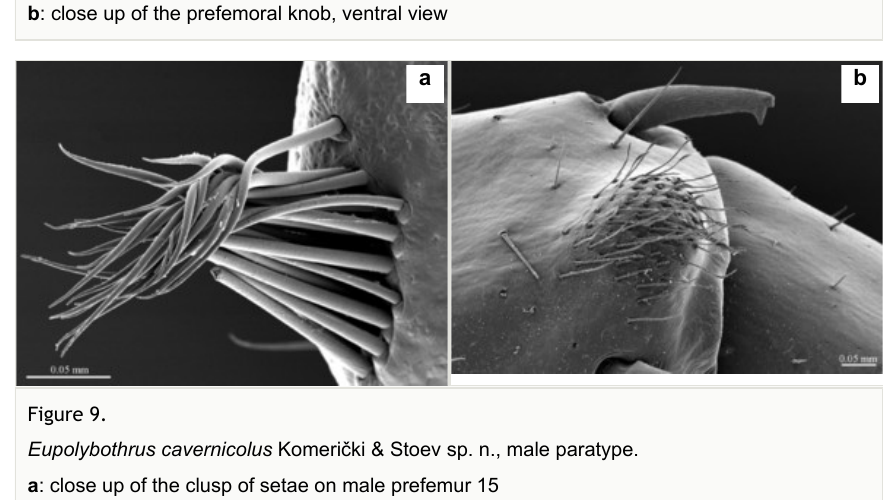
Figure 9. Eupolybothrus cavernicolus Komerički & Stoev sp. n., male